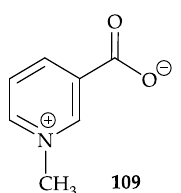
Figure 18. Structure of trigonelline ( 109 ).